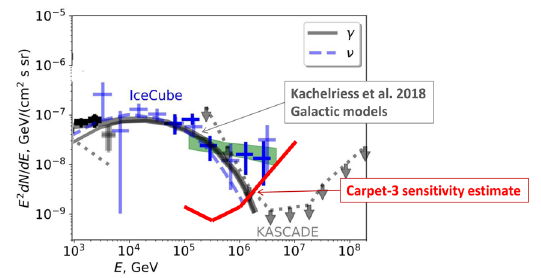
Figure 2. Estimated Carpet–3 sensitivity (95% CL, one year of live time) to the di ff use gamma-ray flux (red line) superimposed on the plot with Galactic model predictions from Ref.